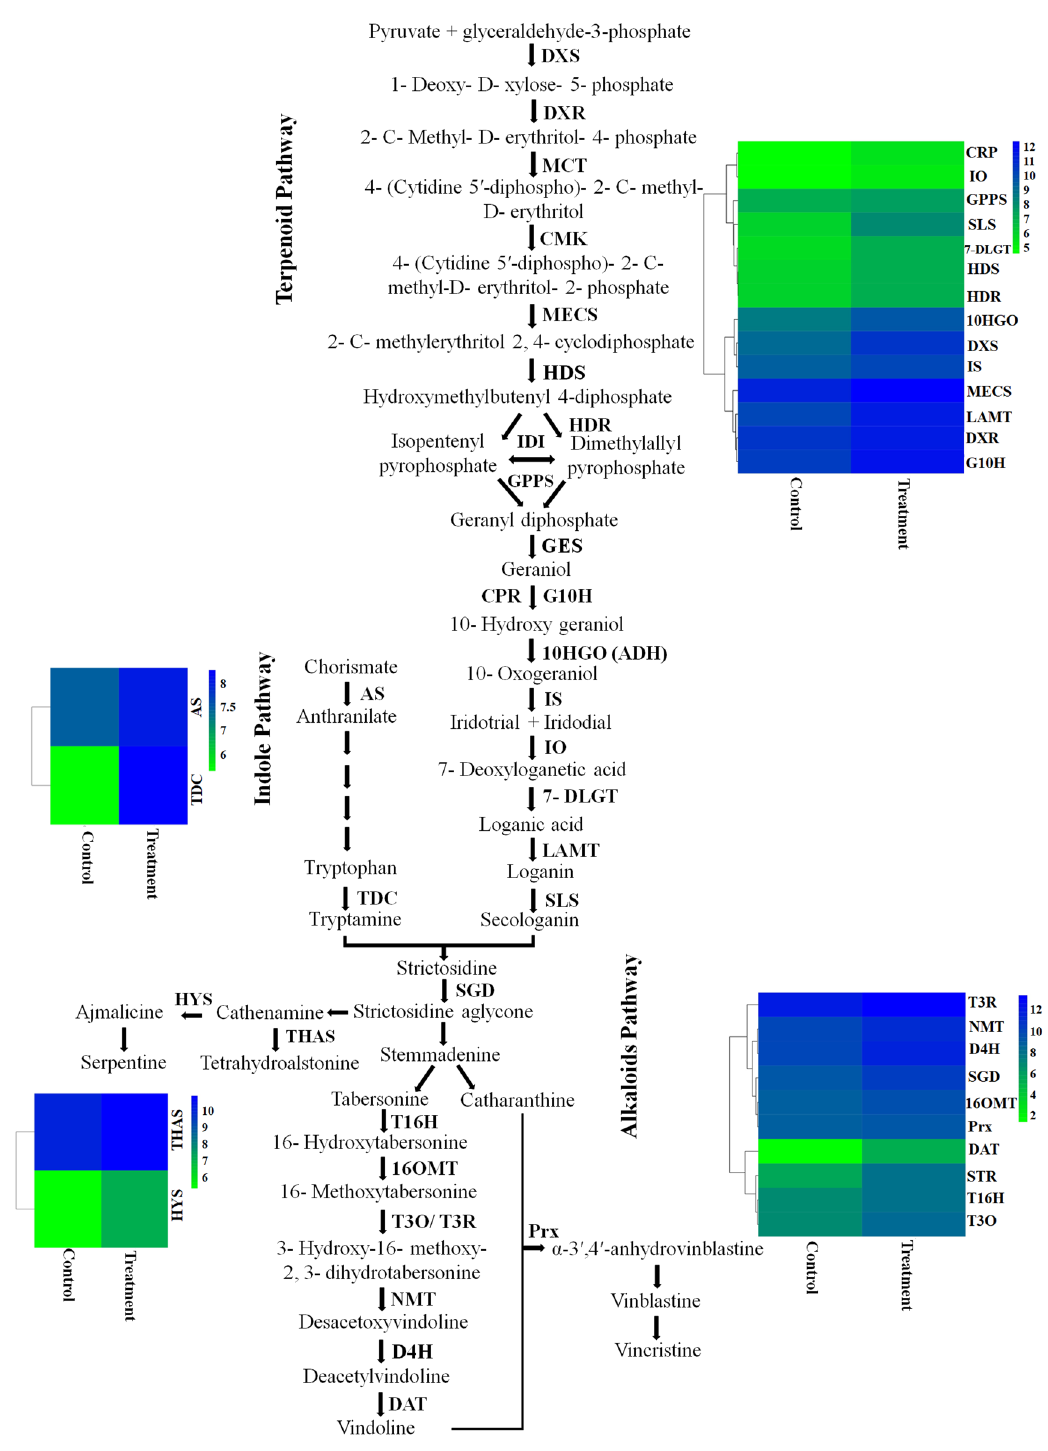
Figure 4. Expression patterns of C. roseus genes involved in the terpenoid indole alkaloids biosynthetic